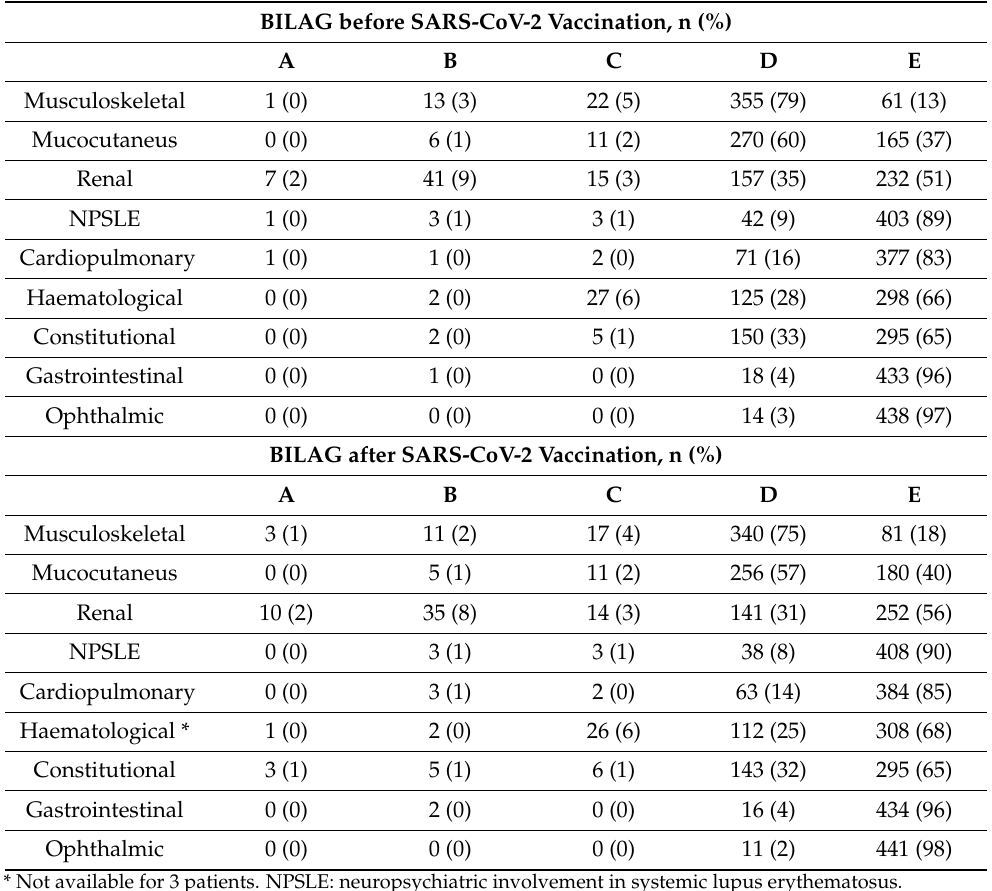
Table 4. BILAG score before and after SARS-CoV-2 vaccination. BILAG before SARS-CoV-2 Vaccination, n (%)